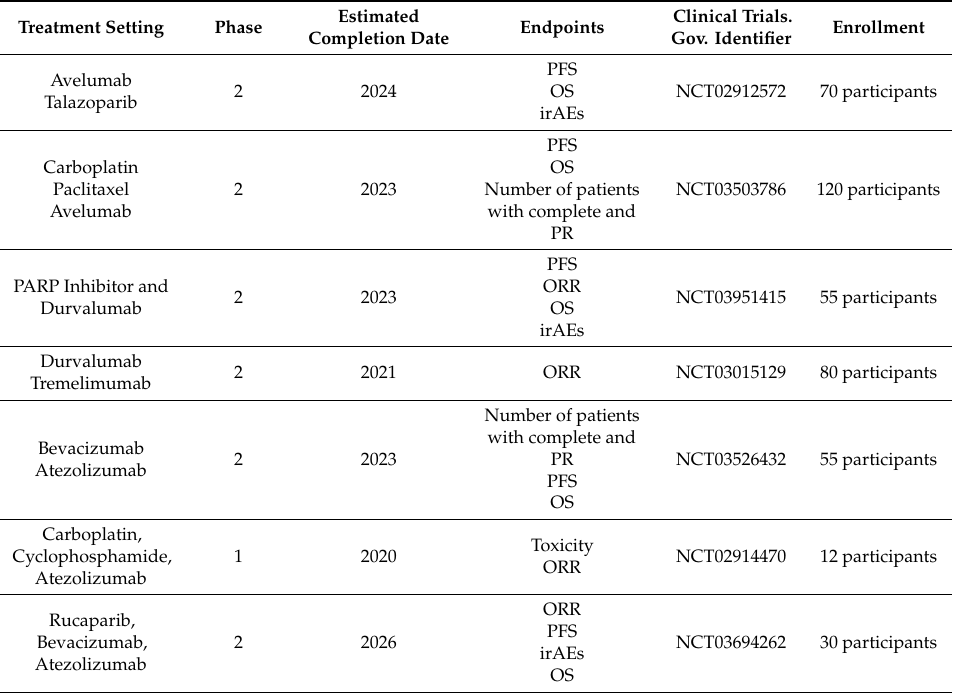
Table 5. Ongoing trials (up to February 2020) of PD-L1 inhibitors in uterine